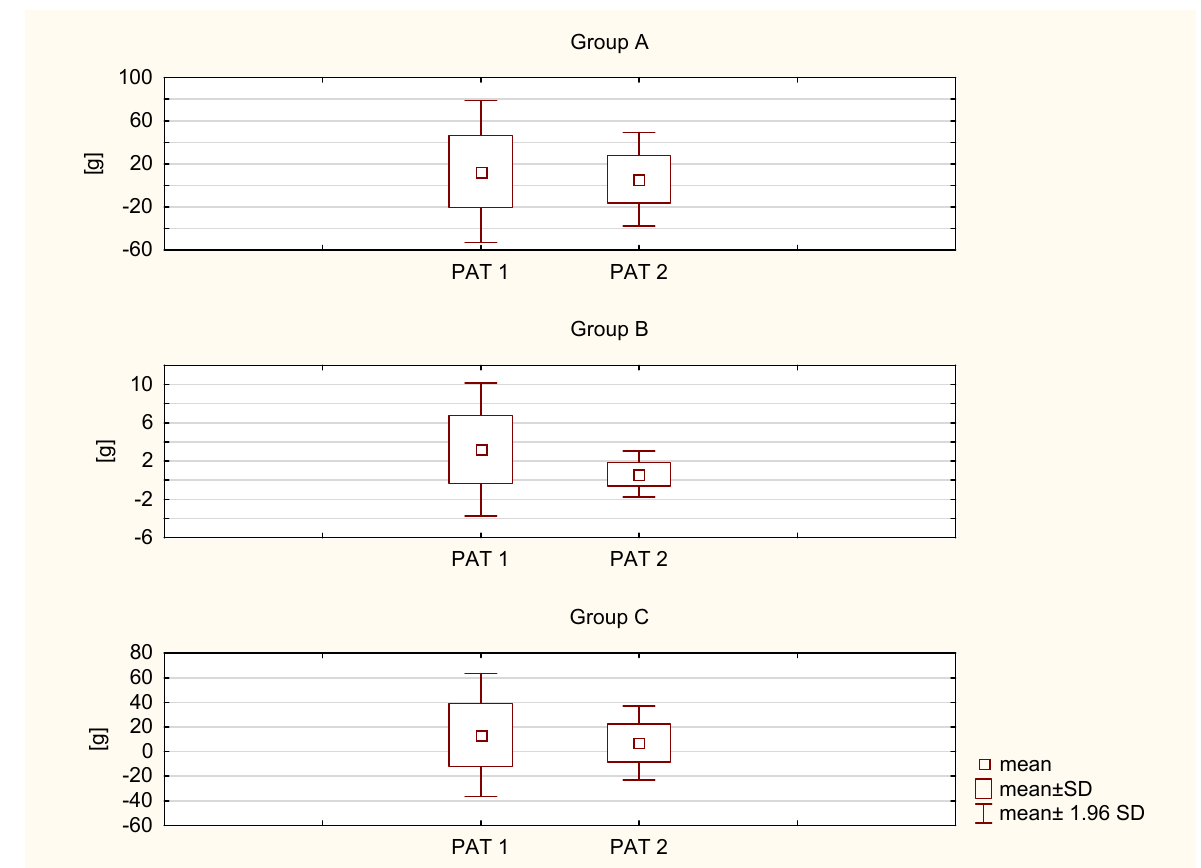
Figure 1. Comparison of PAT 1 and PAT 2 in individual groups.